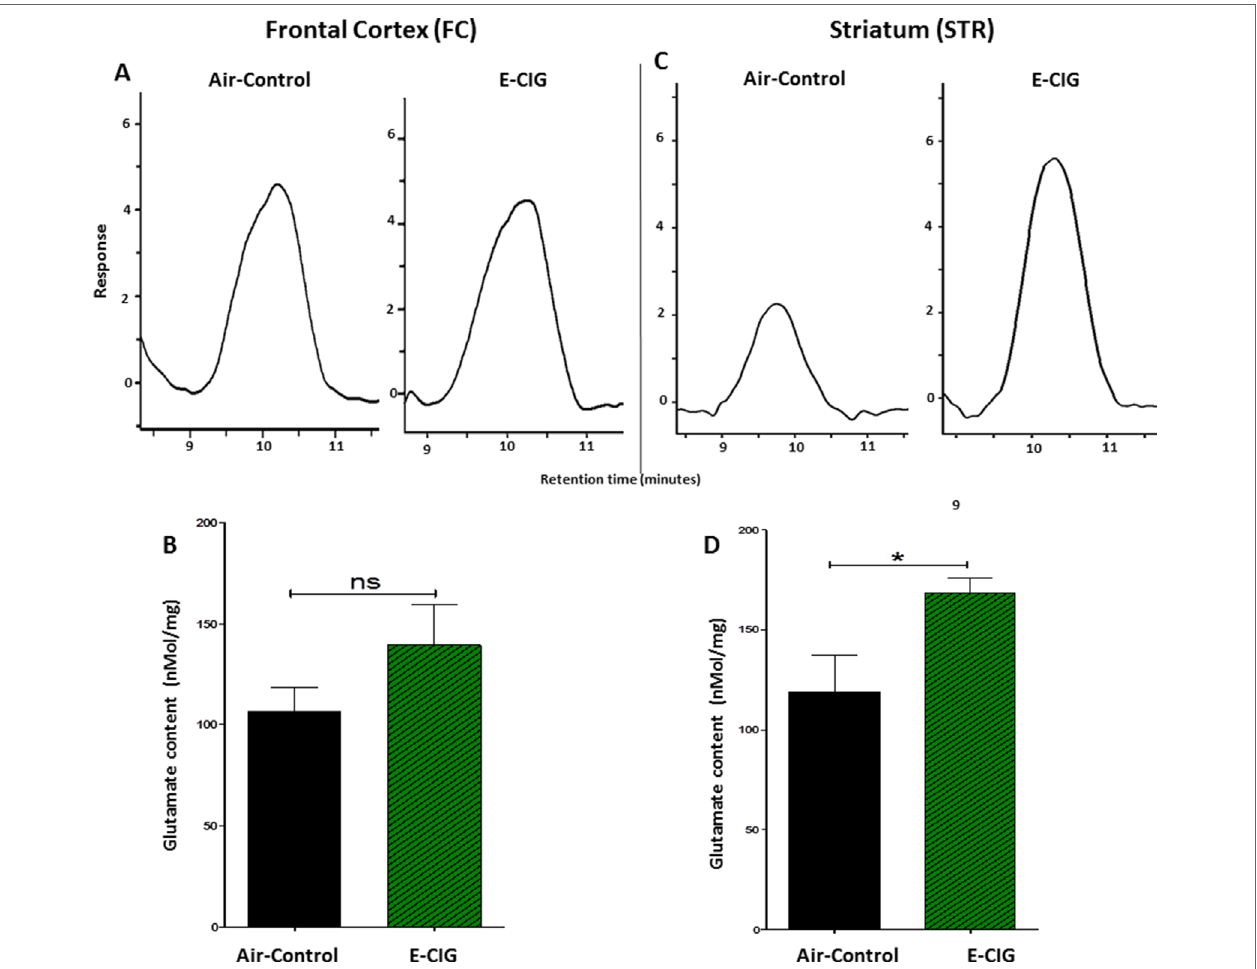
FIGURE 3 | Effects of inhalation of E-CIG fox 6 months on glutamate concentrations in the FC and STR in male C57BL/6 mice. (A) Peaks of glutamate in the FC in air controls and E-CIG groups. (B) Independent t -test analysis did not show any significant alterations in glutamate concentration in the FC between E-CIG and air controls. (C) Peaks of glutamate in the STR for air control and E-CIG groups. (D) Independent t -test analysis revealed significant elevations in glutamate concentration in the STR in E-CIG vapor–exposed group compared to air controls. Data are reported as mean ± SEM (* p < 0.05, ns, not significant), ( n = 5 for each group), ( X -axis, retention time [minutes], Y -axis,